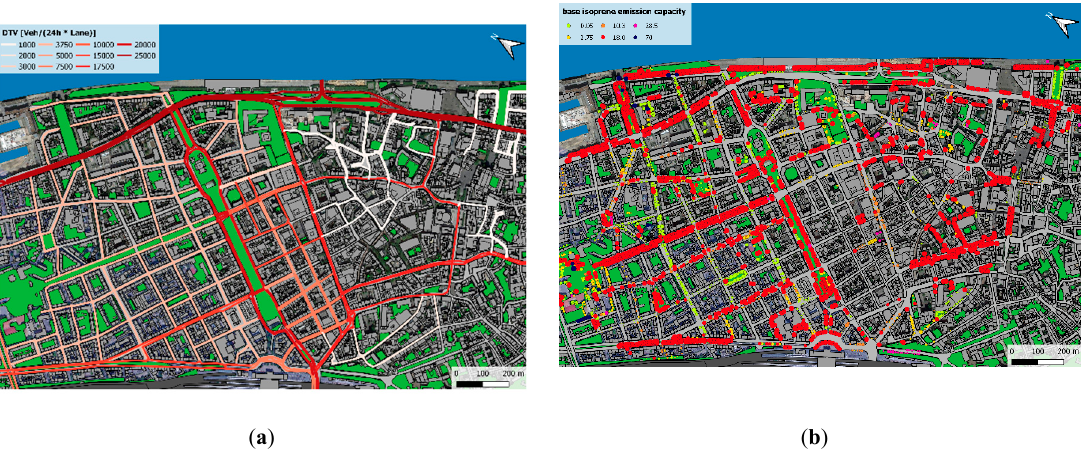
Figure 5. ( a ) Model domain 7.5 km with road traffic and ( b ) tree inventory where data was available. Tree species classified in 6 categories according to their base isoprene emission capacity [µg isoprene g − 1leaf h − 1 ] (Table 4).